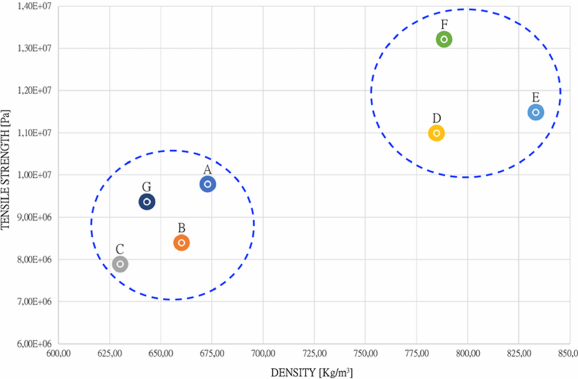
Figure 7: Graph of Tensile Strength/Density